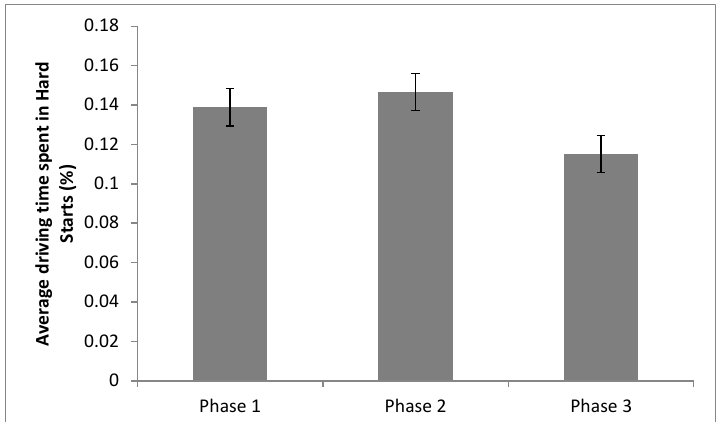
Figure 1. Average percentage of driving time in Hard Starts